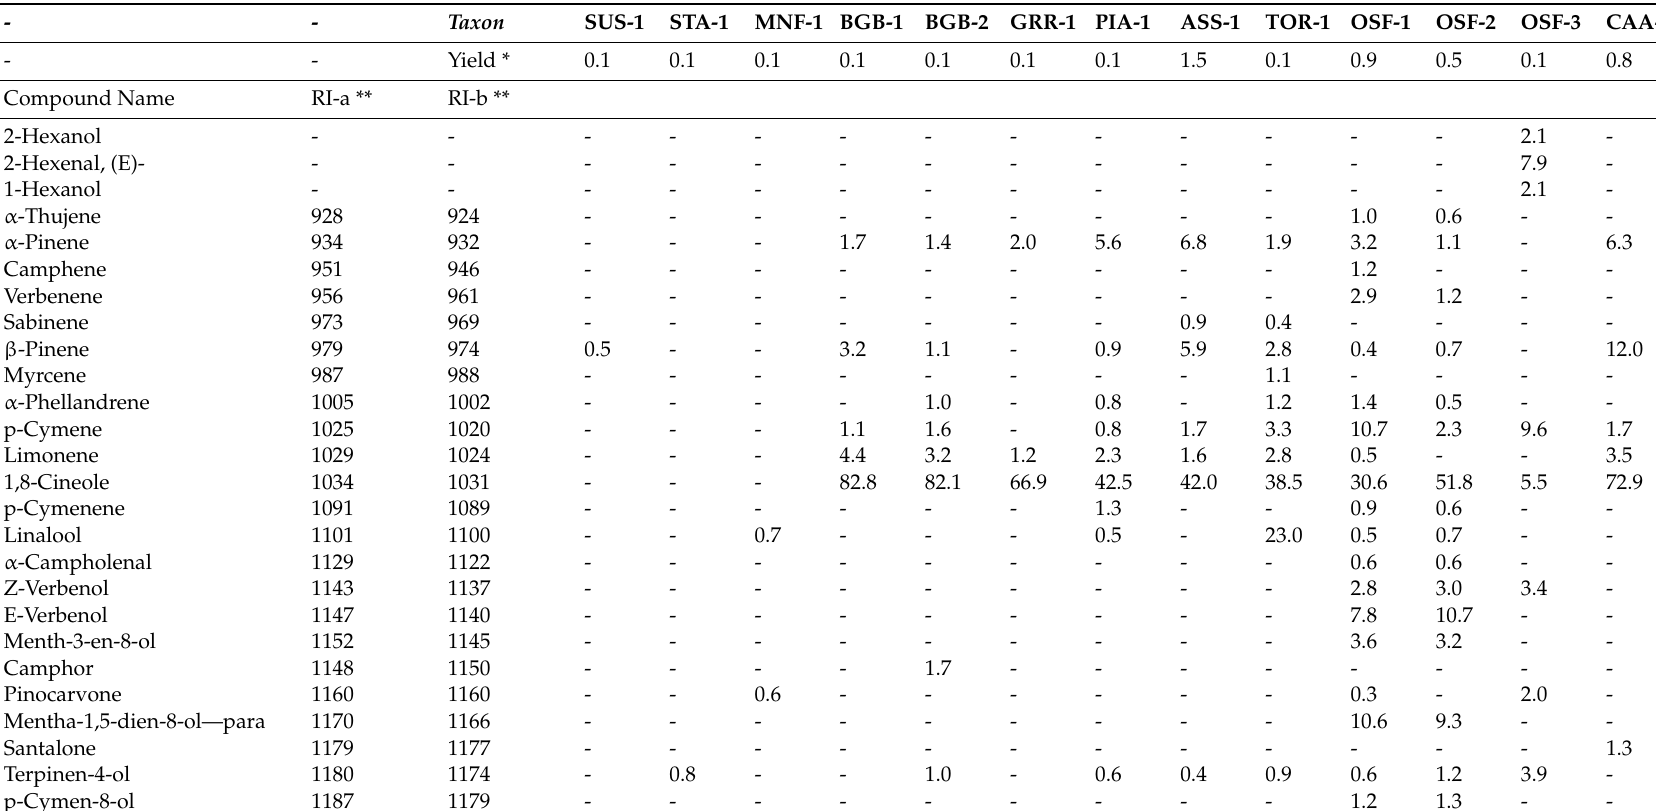
Table 4. Chemical character of essential oils from maaliol producing species, and P. incisa from Blue Mountains. Yield is in % g / g fresh leaf weight, AI is arithmetic index and Pub. AI is the published reference value of arithmetic index. SUS = P. suborbicularis , STA = P. striatiflora , MNF = P. sp. Minyon Falls, OSF = P. sp.